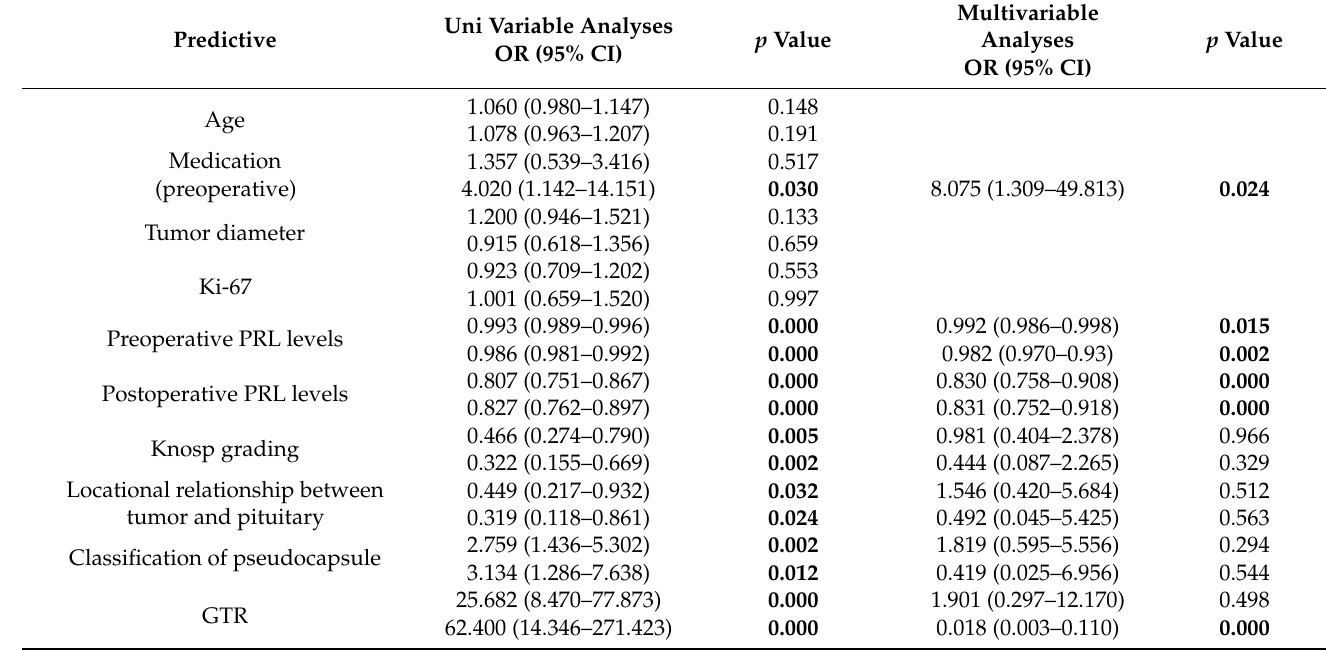
Table 5. Predictors of surgical remission positive outcome and postoperative recurrence.